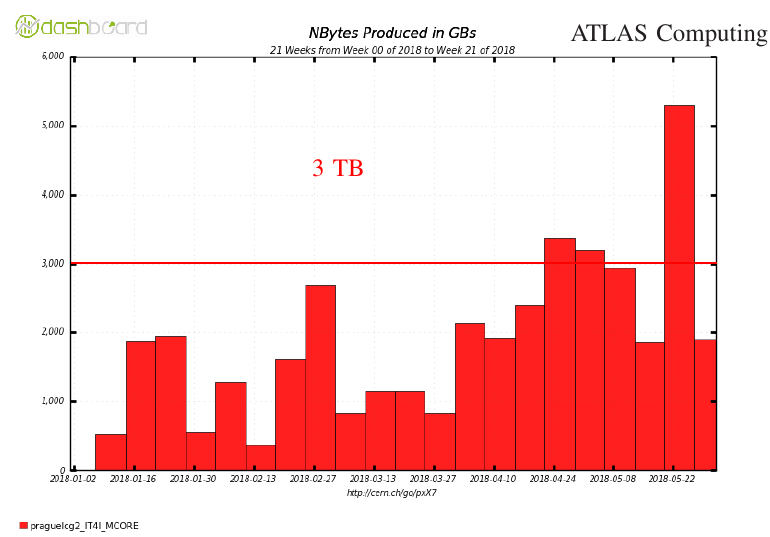
Figure 4. Amount of data produced every week